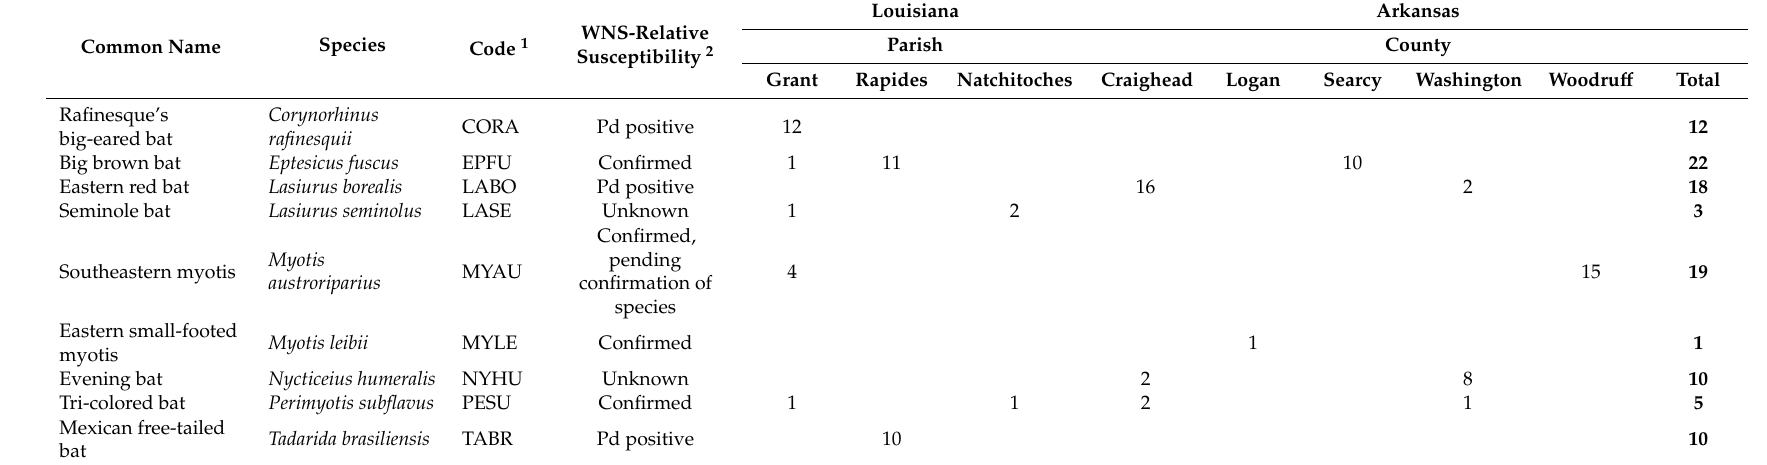
Table 1. Locations and bat species from which VOC air samples were collected and indications of relative susceptibility to White-Nose